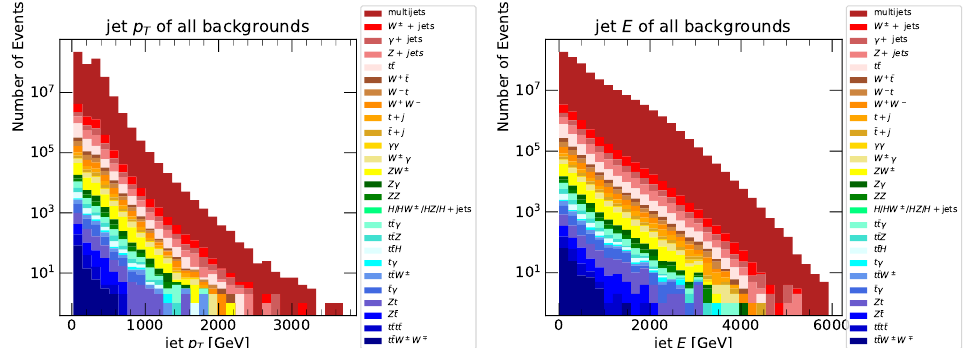
Figure 2: Transverse momentum p all